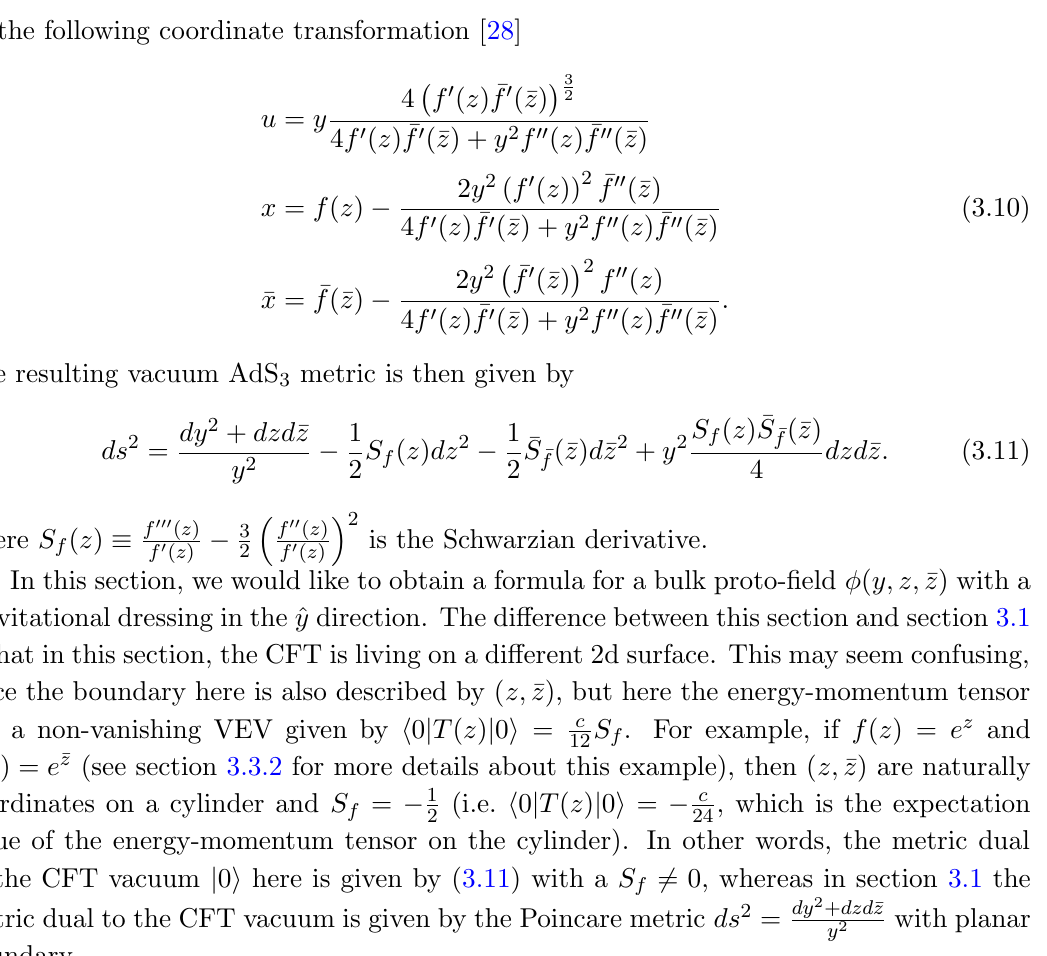
Figure 3 . This figure suggests the use of a diffeomorphism to generate a natural gravitational dressing for a CFT living on a curved space, such as the cylinder. A curved dressing in the ( u, x, ¯ x ) coordinates, with the CFT living on a plane, is mapped using equation (3.10) to a radial dressing in global AdS and BTZ black hole